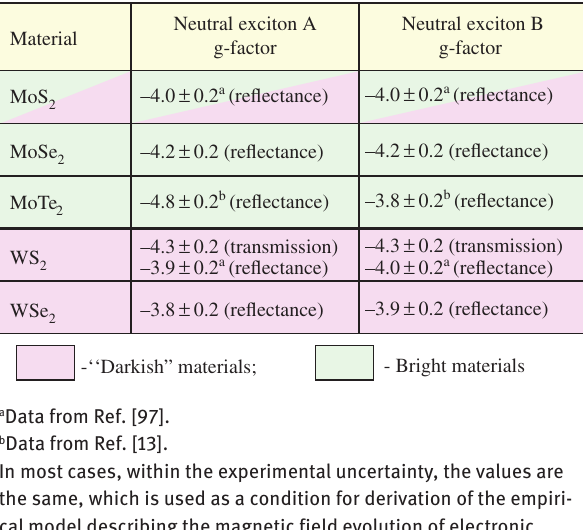
Table 2: A comparison between the values of the g-factors of the neutral excitons A and B for monolayers of different representatives of S-TMDs, as obtained from the measurements of the reflectivity or transmission